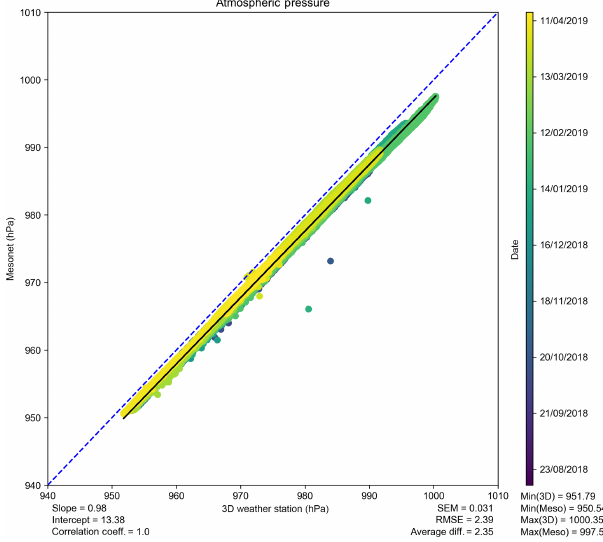
Figure 6. Comparison of the temperature from the low-cost HTU21D sensor ( x ) and the Oklahoma Mesonet ( y ) for 6 months of the deployment, color-coded by time. The one-to-one reference line (blue dashed) and linear regression line (black solid) are overlaid.